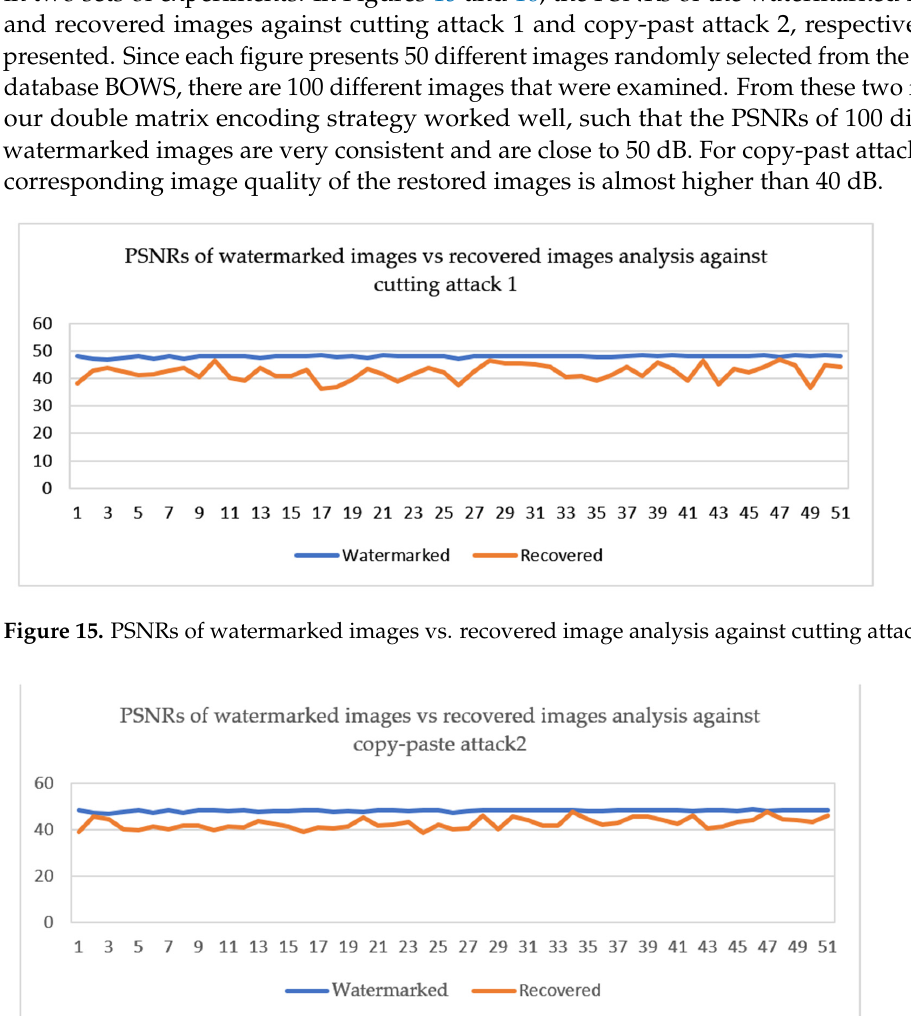
Figure 16. PSNRs of watermarked images vs. recovered image analysis against copy-past attack 2.